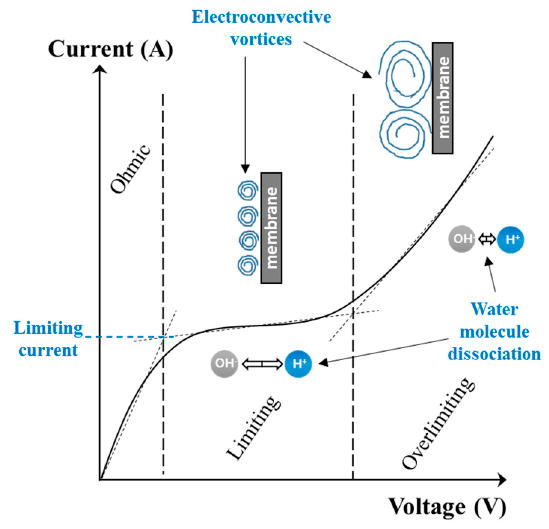
Figure 11. Typical current-voltage curve, appearance of electroconvective vortices and intensity of water molecule dissociation (Adapted from Bazinet and Castaigne [11]).